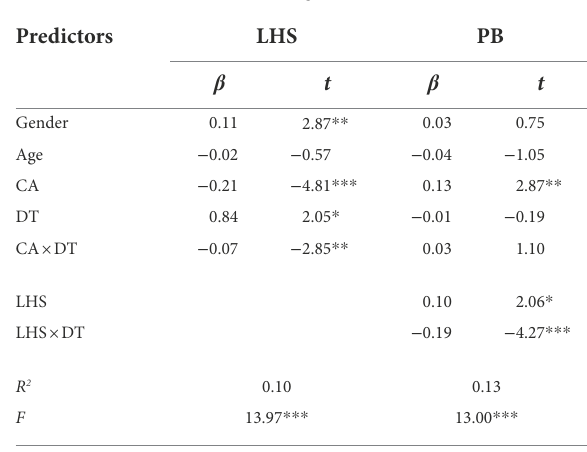
TABLE 3 Moderated mediation